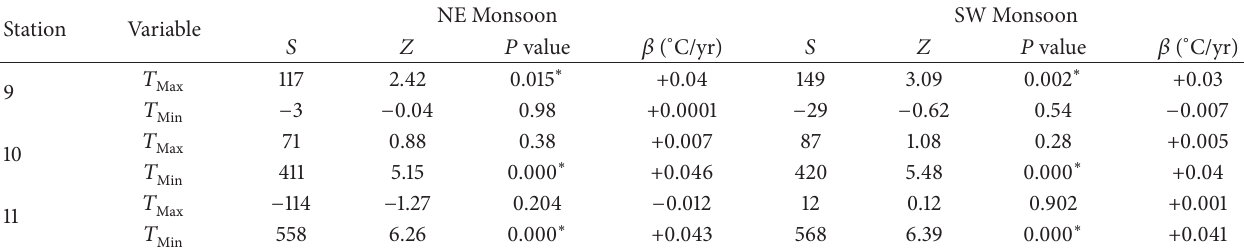
Table 7: The results of the MK and TSS methods for seasonal temperature variables in the Langat River